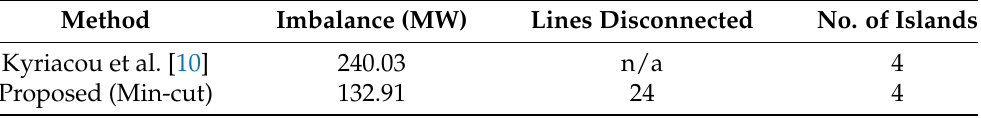
Table 3. Comparison of the proposed method with the literature on case 118.